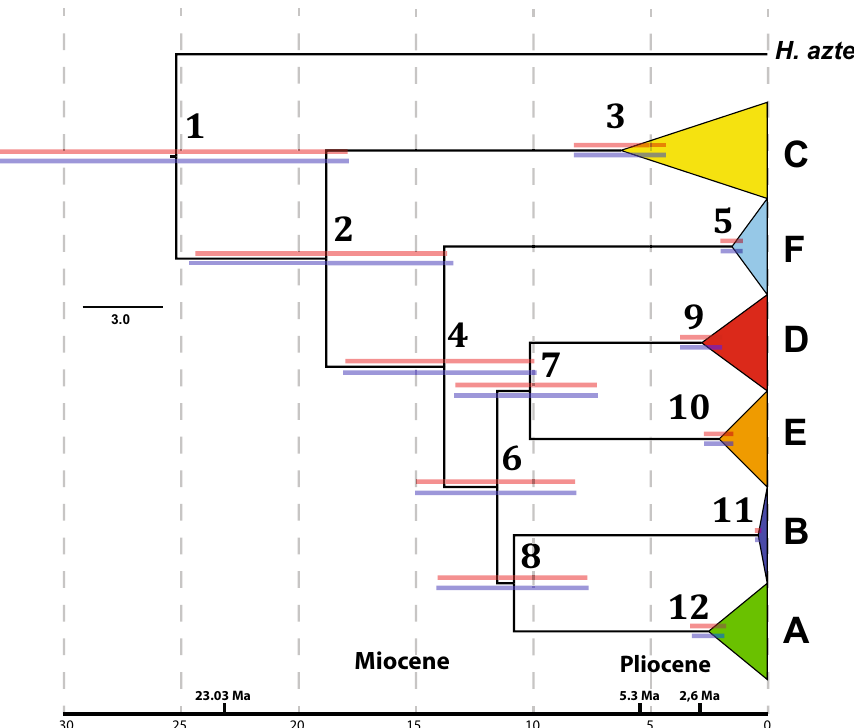
Figure 4. Simplified dated phylogeny (chronogram) of Hyalella based on the 13 mitochondrial protein-coding genes. The ages of two nodes were implemented separately as constraints to calibrate the relaxed molecular clock (MRCA of node A and tree root after Adamowicz et al. 14 ). Blue and red bars above nodes indicate 95% higher posterior densities for node ages when using 2.8 ± 0.4 Ma as age constrain for clade A and 20.63 Ma for the tree root, respectively. Nodes are numbered for discussion in the main text (nodes 1–12). Trees are available in nexus format in the GitHub repository (https ://githu b.com/Fraza pel/Hyale lla-amphi pod-Phylo genom ics).